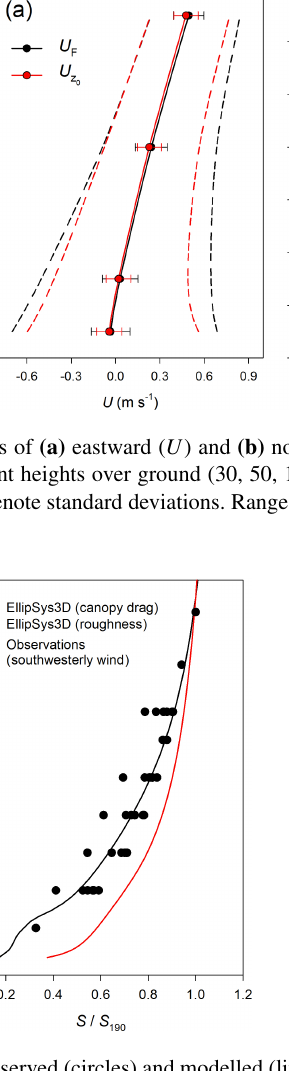
Figure 7. Normalized observed (circles) and modelled (lines) wind speed profiles at the mast position in Rödeser Berg site for wind direction sector around 190 ◦ . Modelled results plotted for the case with full description of canopy drag forces (black) and the case with forest replaced by the effective roughness